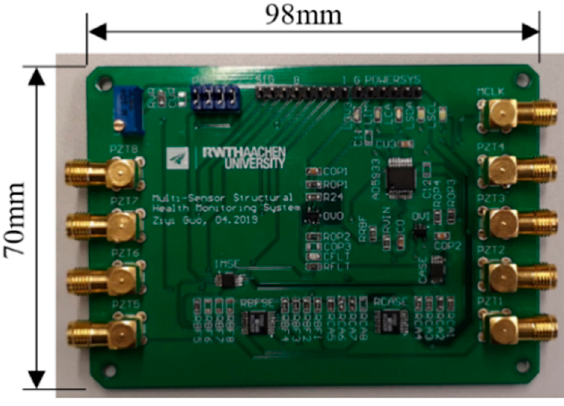
Figure 6. Photo of the designed hardware system.